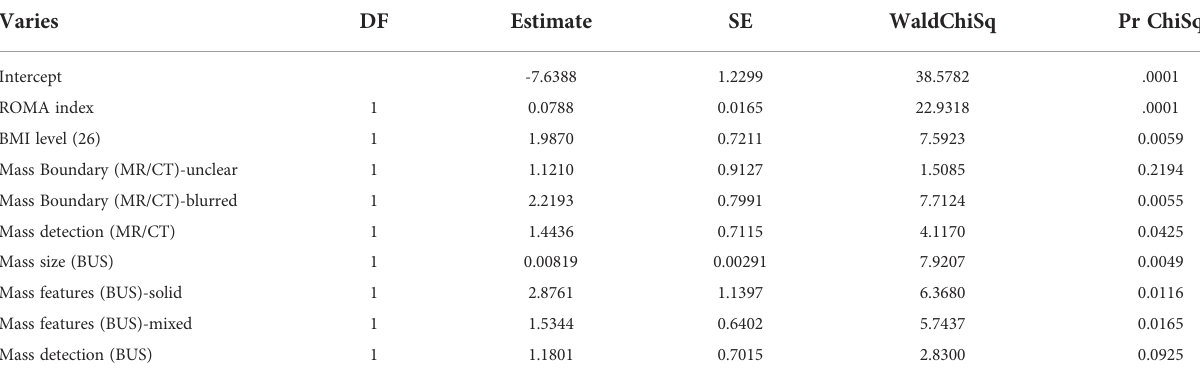
TABLE 2B Multivariate logistic regression analysis.